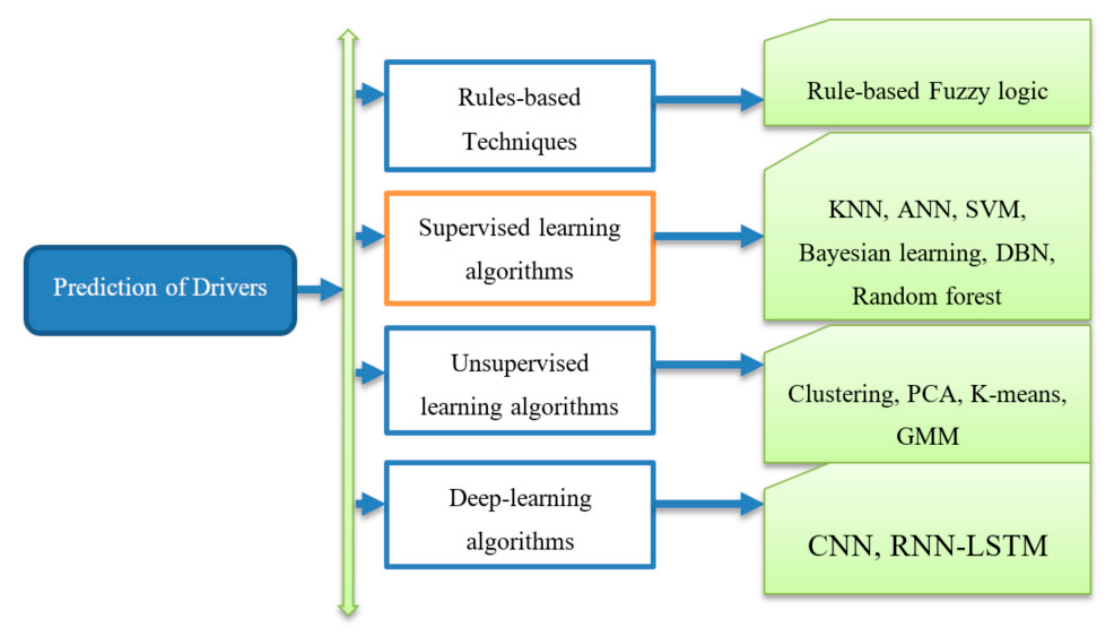
Figure 9. State-of-the-art artificial intelligence and machine-learning algorithms used in the past for predicting driver fatigue. GMM: Gaussian mixture modeling, ANN: artificial neural network, SVM: support vector machine, PCA: principle component analysis, CNN: convolutional neural network, RNN–LSTM: recurrent neural network long-short term memory.